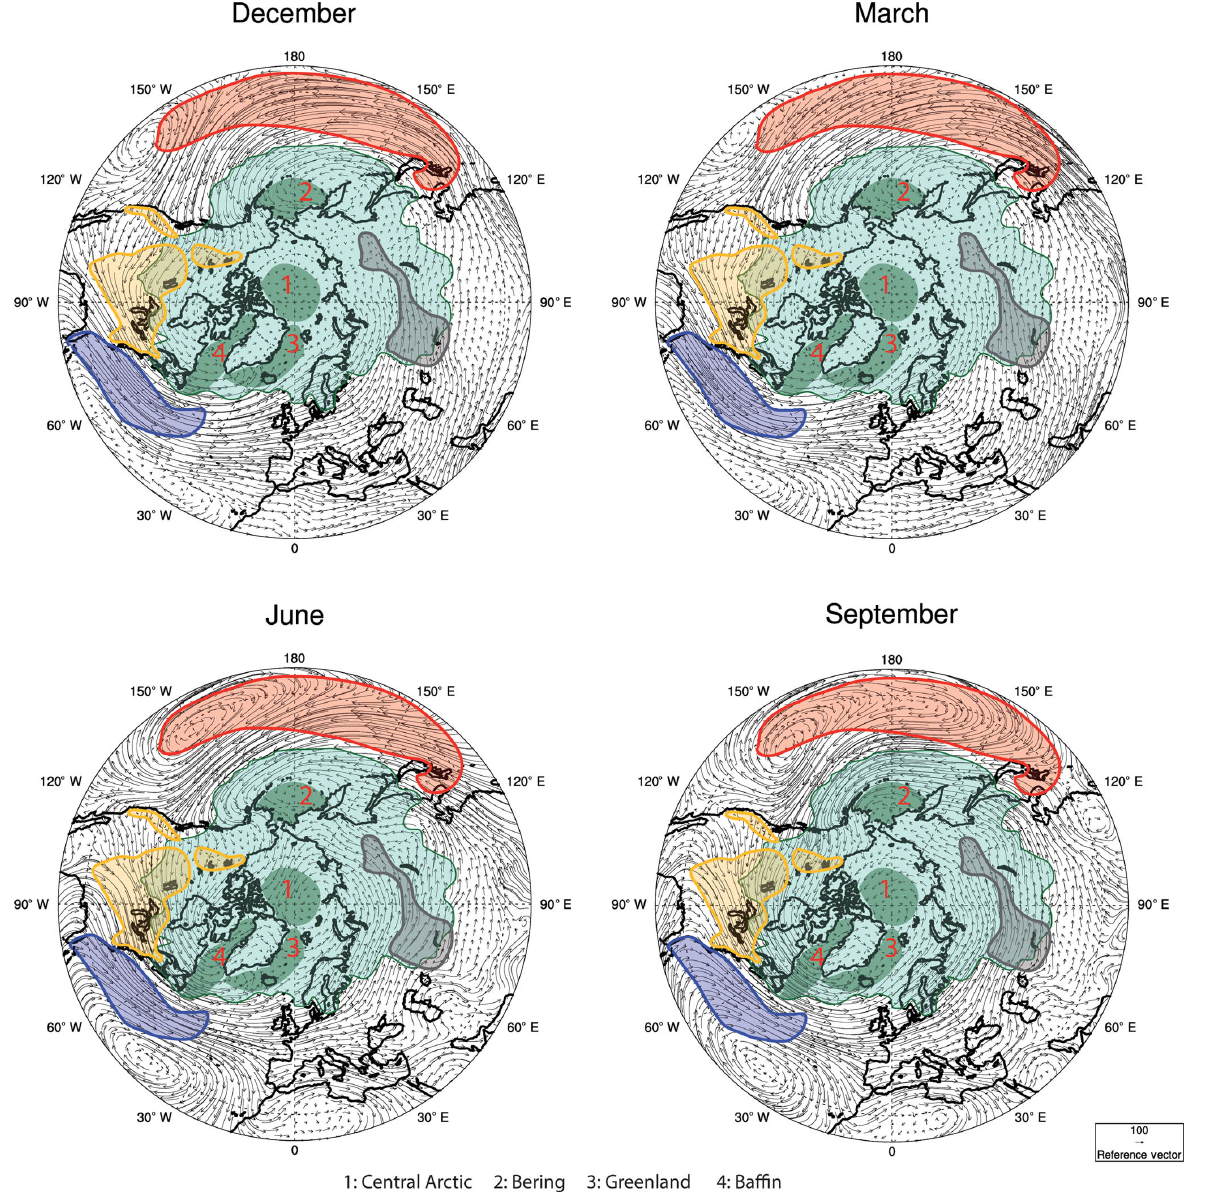
Figure 2. Climatological values of the vertical integrated moisture flux (VIMF) (vector, kgm − 1 s − 1 ) for the first month of each season together with the main Arctic sources identified by Vázquez et al. (2016). The light green filled area represents the Arctic region as defined by Roberts et al. (2010), and the dark green areas represent the AO subregions that receive most moisture from the source